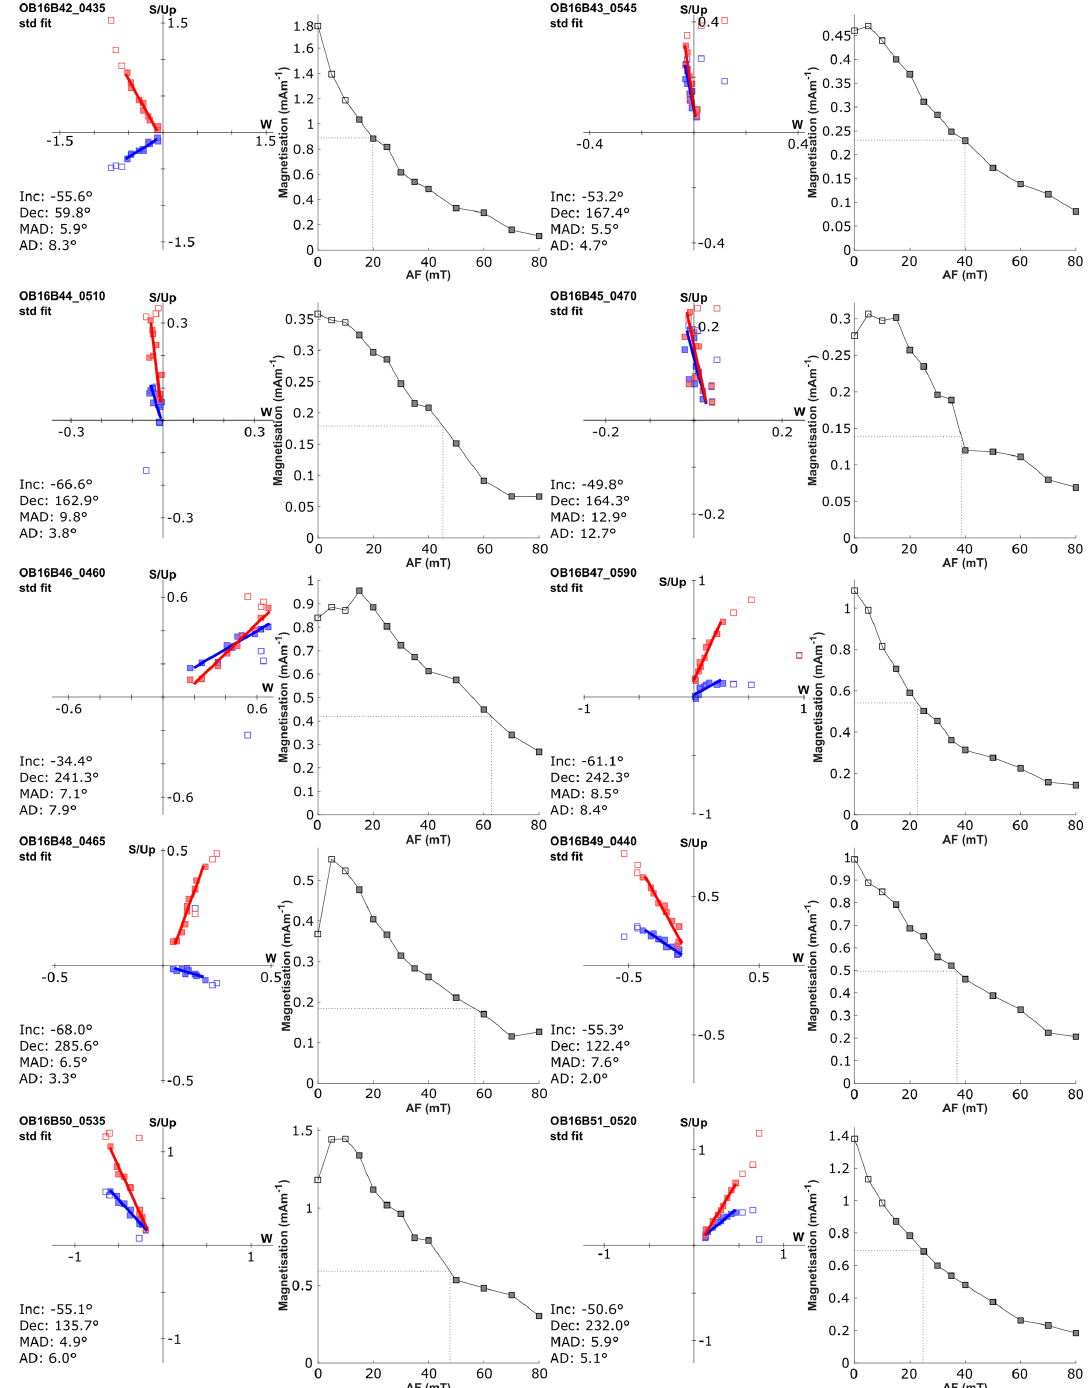
Figure C1. Orthogonal plots and intensity of magnetisation after stepwise demagnetisation of pilot samples OB16B42-51.